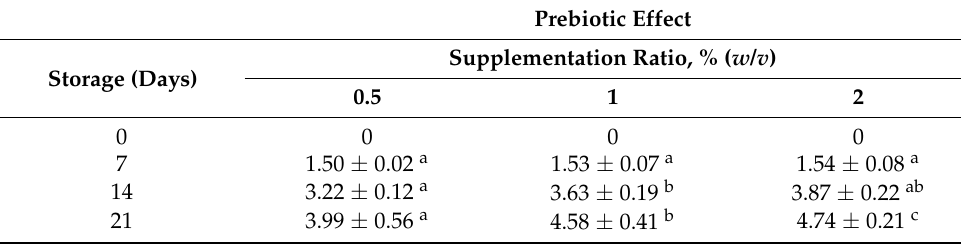
Table 2. Potential prebiotic effect of freeze-dried apple pomace supplementation of MRS broth for Loigolactobacillus bifermentans MIUG BL 16.